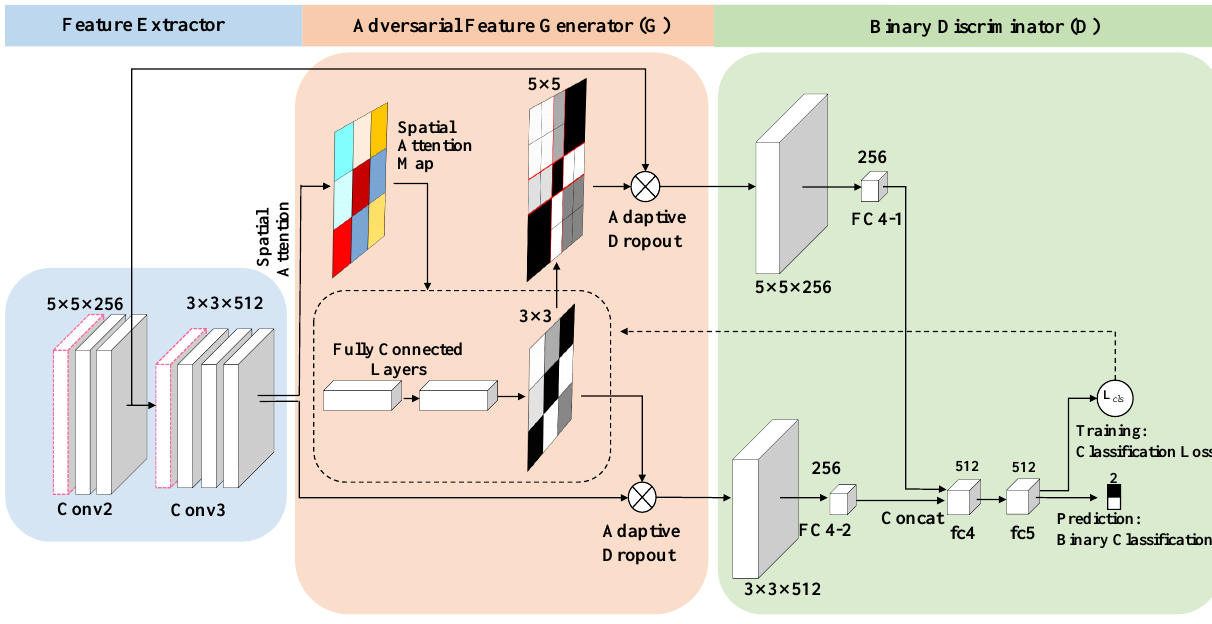
Figure 2. The architecture of AMGN-based object-tracking